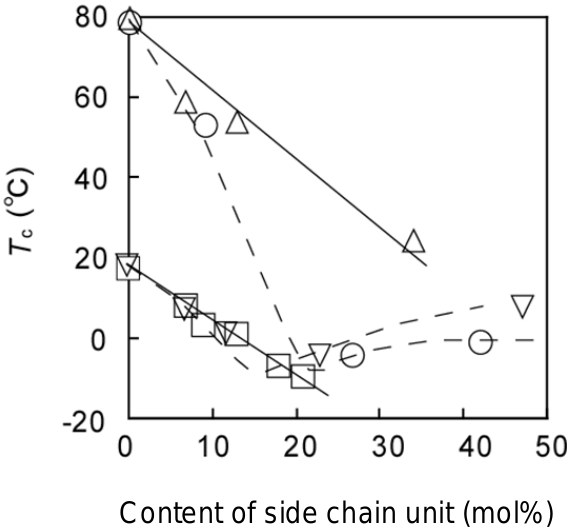
Figure 5. T of PBS/M-6 ( △ ), PHS/M-6 ( □ ), PBS/M-16 ( ○ ) and PHS/M-16 ( ▽ ) with c various monomer contents.